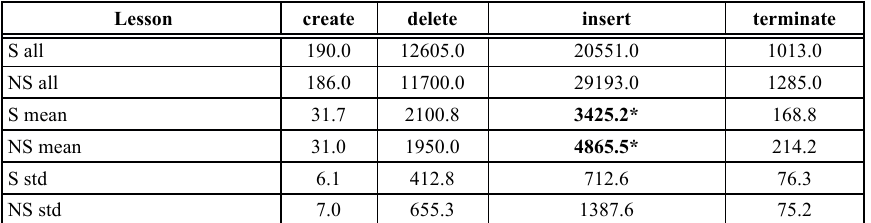
Table 2. Actions of each type, logged in STEAM (S) and non-STEAM lessons (NS) by the